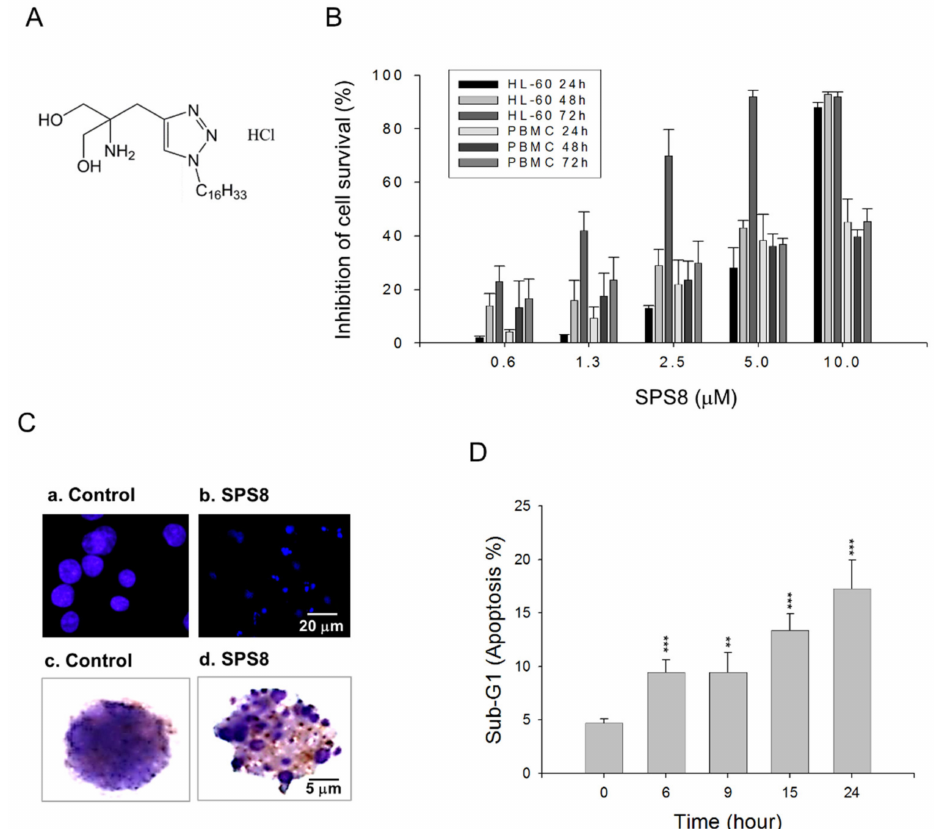
Figure 1. E ff ect of SPS8 on cell viability of HL-60 cells. ( A ) Chemical structure of SPS8. ( B ) Graded concentrations of SPS8 were added to HL-60 or human peripheral blood mononuclear cells (PBMCs, purchased from Zen-Bio Inc. Research Triangle Park, NC, USA) for 24, 48, or 72 h. The cytotoxic e ff ects were determined by an MTT assay. ( C ) HL-60 cells were incubated in the absence or presence of SPS8 (5 µ M) for 24 h. DAPI nuclear staining (a,b) and Giemsa staining (c,d) were performed. ( D ) HL-60 cells were incubated in the absence or presence of SPS8 (5 µ M) for the indicated times. A flow cytometric analysis of DNA staining with propidium iodine was performed. Data are expressed as the mean ± SEM of three independent experiments. ** p < 0.01 and *** p < 0.001 compared with the